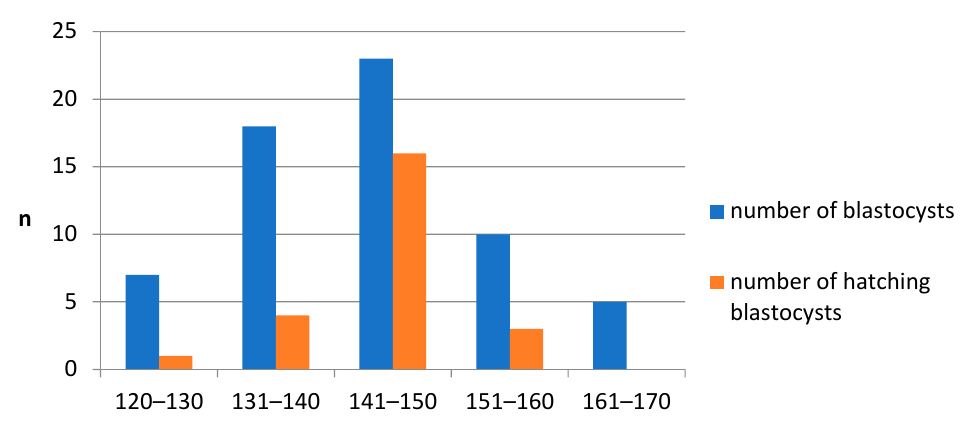
Figure 3. The relationship between the time of cavity formation and the hatching ability in domestic cat blastocysts. Blastocysts that formed between 141–150 hpi had a significantly higher incidence of hatching ( p < 0.001).